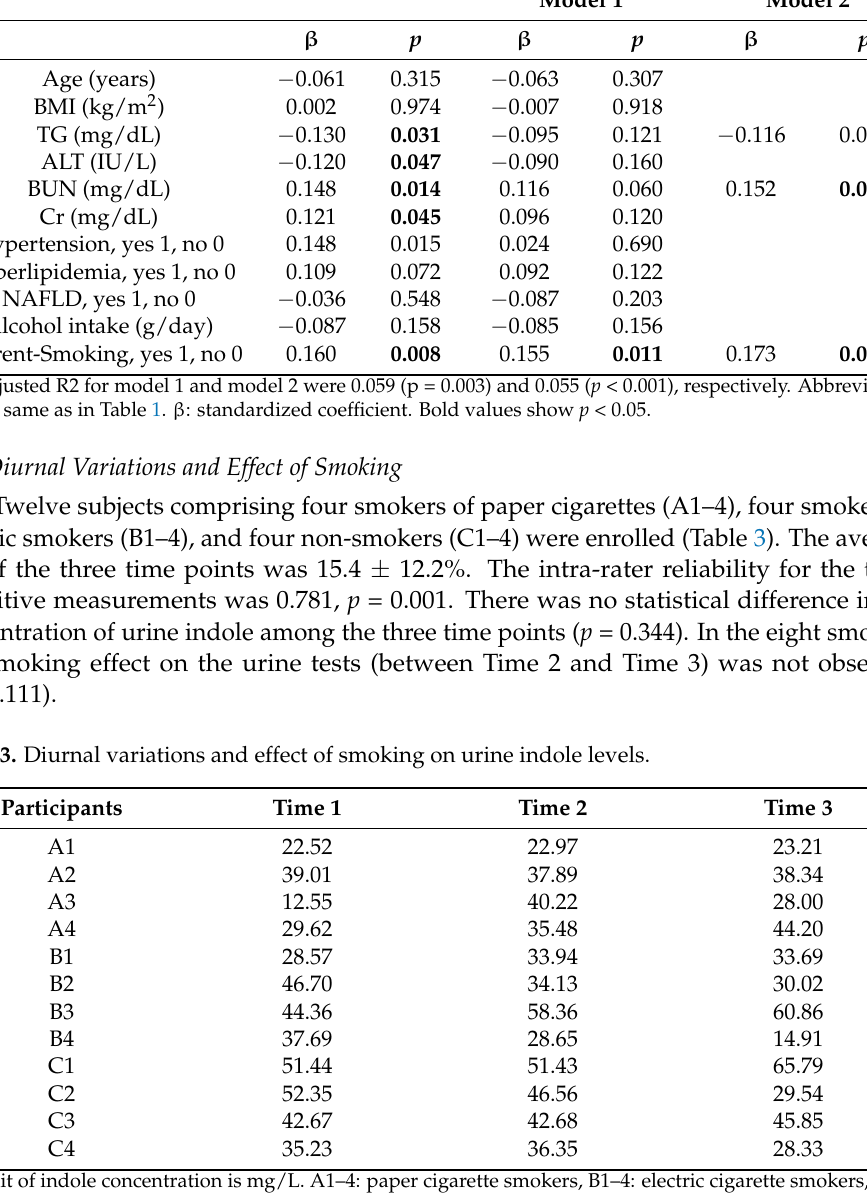
Table 2. Univariate and multivariate regression analysis for urine indole levels. n = 273 Univariate Multivariate Model 1 Model 2